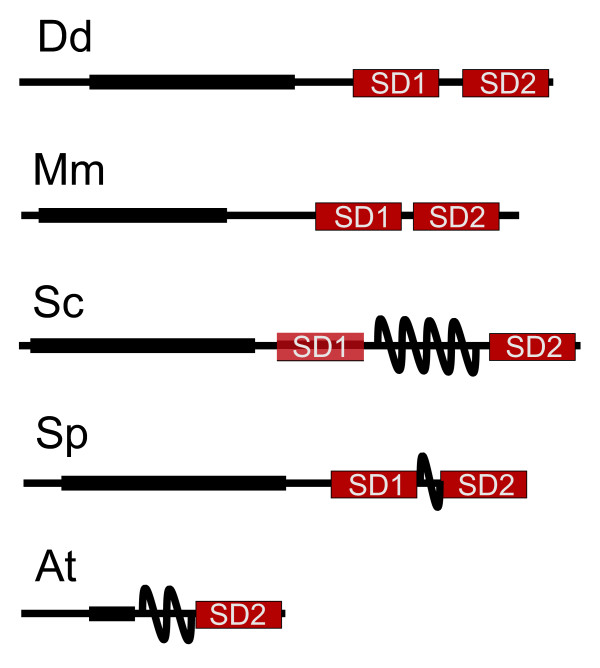
Domain architecture of RENi proteins. Red boxes: SUMO-related domains (labeled SD1 and SD2 respectively), black thick lines: low complexity regions. Species code and accession numbers as in Figure 1. Black waves indicate long helical regions (>20 AA), conserved among close relatives.